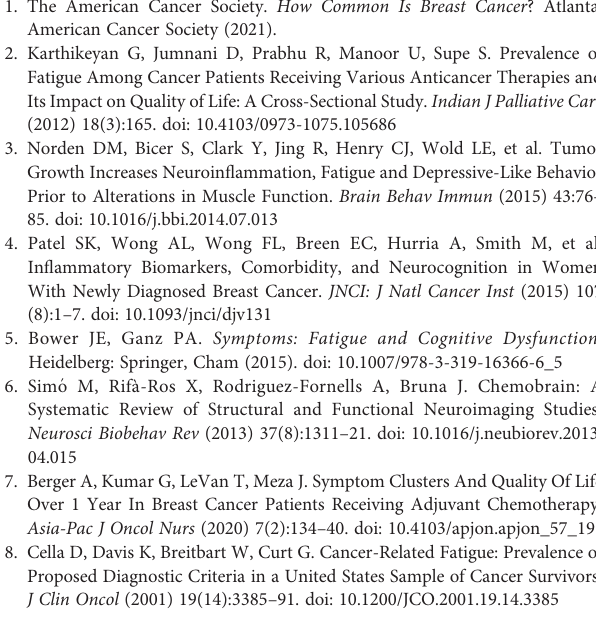
Supplementary Figure 1 | Ovariectomy induces menopausal-like state in Balb/c mice. (A) Ovariectomy halts estrous cycling. (B) Ovariectomy signi fi cantly decreases circulating estrogen concentrations. Supplementary Figure 2 | Paclitaxel chemotherapy increased Icam expression in the frontal cortex but not the hippocampus following the fi nal dose in survivor mice. (A) Hippocampus, (B) Frontal cortex. Unpaired parametric two-tailed t tests were used for statistical analyses. Nonparametric Mann-Whitney U tests were used when the assumptions of normality and equal variances were not met. *p<0.05 Supplementary Figure 3 | Paclitaxel chemotherapy does notalter Iba-1 or GFAP percent area in the hippocampus or hypothalamus following the fi nal dose in survivor mice. (A) Hippocampal Iba-1% area, (B) Hypothalamic Iba-1% area, (C) Hippocampal GFAP % area, (D) Hypothalamic GFAP % area. Paclitaxel n=4, vehicle n=3. Unpaired parametric two-tailed t tests were used for statistical analyses. Nonparametric Mann-Whitney U tests were used when the assumptions of normality and equal variances were not met. *p<0.05. Supplementary Figure 4 | Neither paclitaxel chemotherapy nor aromatase inhibitor treatment affected percent spontaneous alternations. (A) Percent spontaneous alternations in the spontaneous alternations test following the fi nal dose of paclitaxel (n=8/group). (B) Percent spontaneous alternations in the spontaneous alternations test following aromatase inhibitor treatment. Aromatase inhibitor n=5, control n=4. Unpaired parametric two-tailed t tests were used for statistical analyses. Nonparametric Mann-Whitney U tests were used when the assumptions of normality and equal variances were not met.